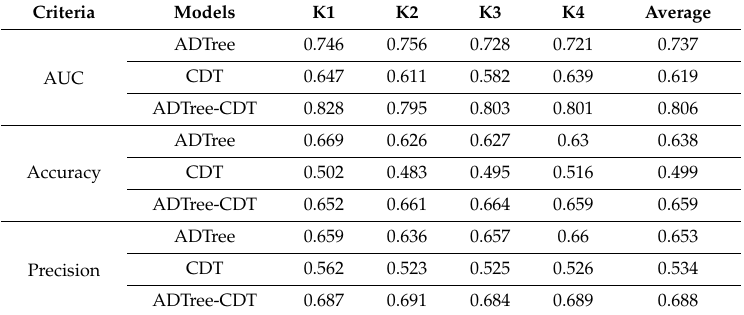
Table 2. The accuracy assessment and validation result of three Machine Learning (ML) models by using area under the curve (AUC), accuracy, and precision index.